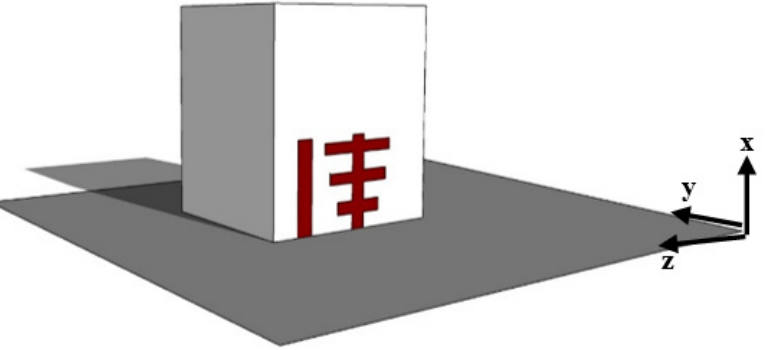
Figure 1. Three-dimensional view of the proposed singly fed Yagi-Uda shape